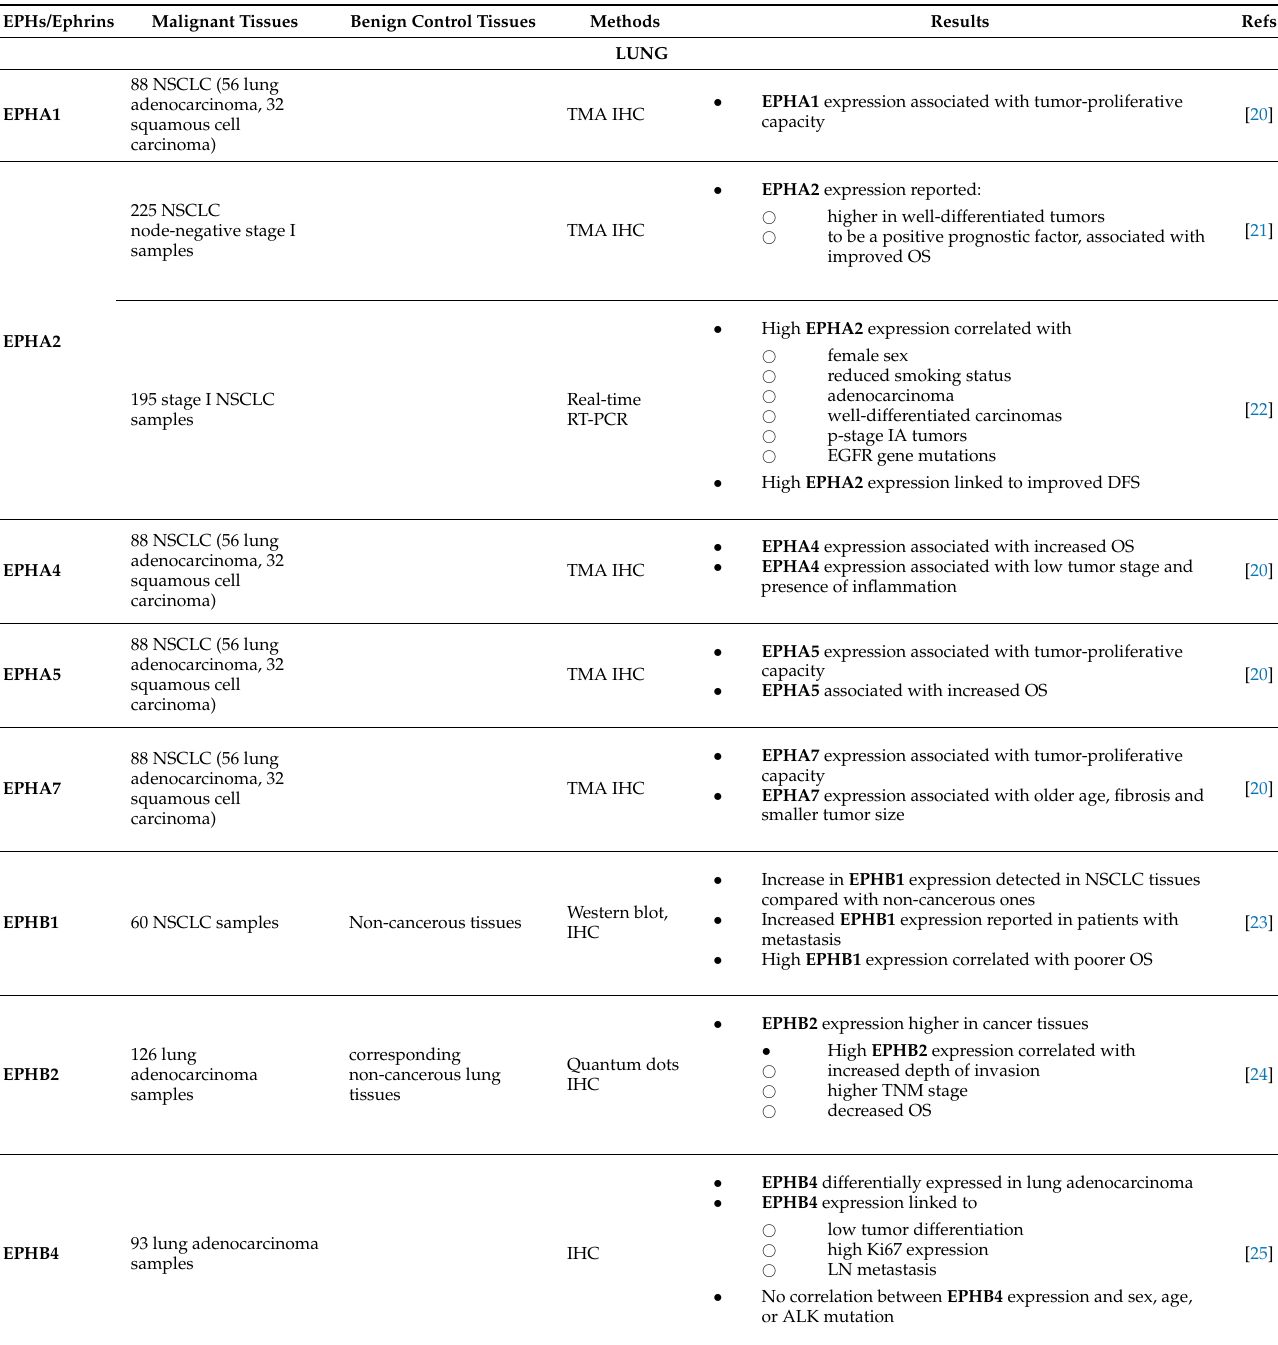
Table 2. EPHs/ephrins(bold)studiedinsolidtumorsoflung, breast, andskinandcorrelationswithclinicopathologicalparameters. EPHs/Ephrins Malignant